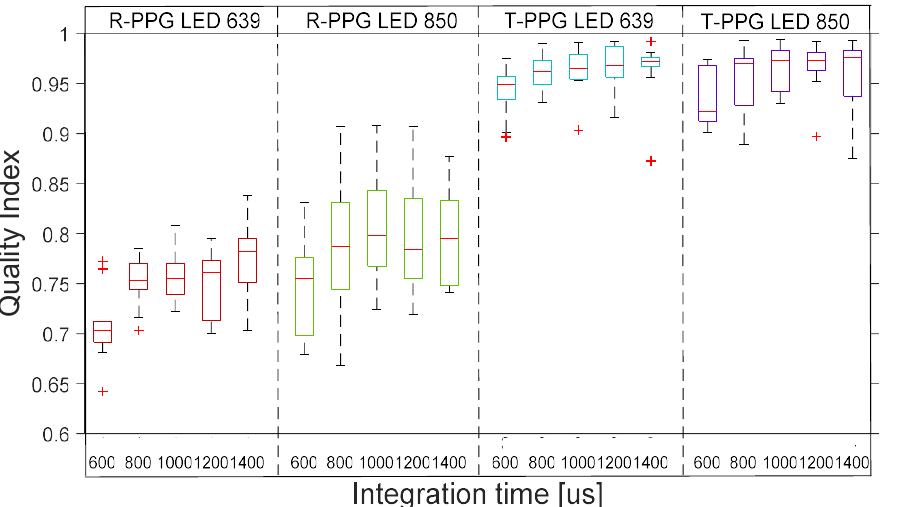
Figure 15. Boxplots of quality index of rPPG signals with 4 different lights at 5 integration times with non-coherent light in transmission and reflection. The inner box divisions indicate: Q1 (the first quartile) to Q3 (the third quartile). The median is marked by a line across the box. The “whiskers” indicate results from Q1 and Q3 to the most extreme data points. The + symbols represent outliers.